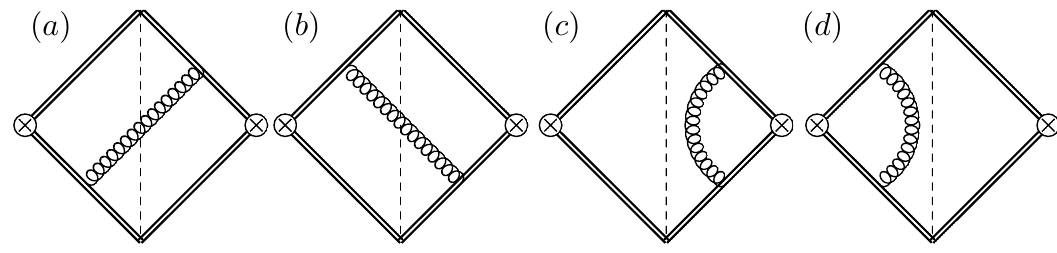
Figure 3 . Diagrams contributing to the angularity soft function at one-loop order. Diagrams (a) and (b) give identical contribution due to